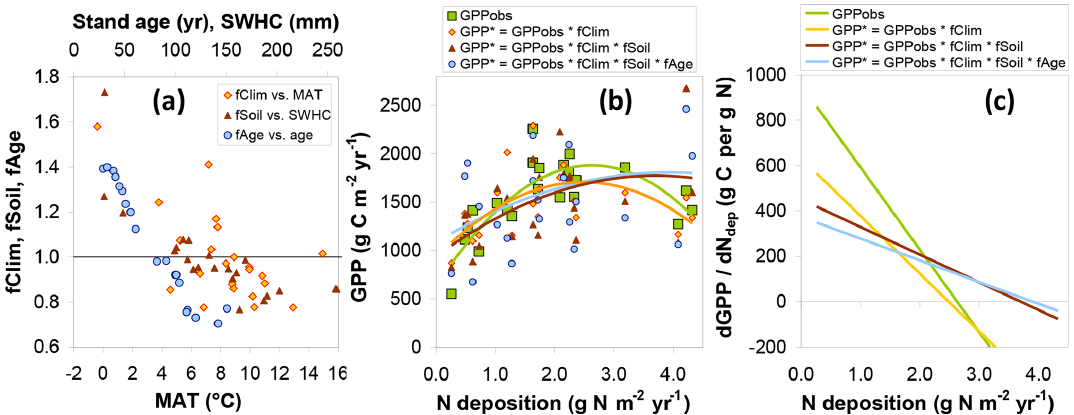
Figure 8. Model-based assessment of the sensitivity of gross primary productivity (GPP) to climate, soil, age and N r deposition. (a) GPP standardization factors for climate ( f CLIM ), soil ( f SOIL ) and age ( f AGE ) for observational (EC-based) data as a function of the dominant climatic and soil drivers (MAT: mean annual temperature; SWHC: soil water holding capacity; see text for details); (b) the resulting stan- dardized GPP ∗ compared with the original GPP obs as a function of N dep (one data point for each of 22 sites), with second-order polynomial fits; (c) estimates of the GPP response to N dep , calculated as the slope of the tangent line to the quadratic fits and plotted as a function of N dep